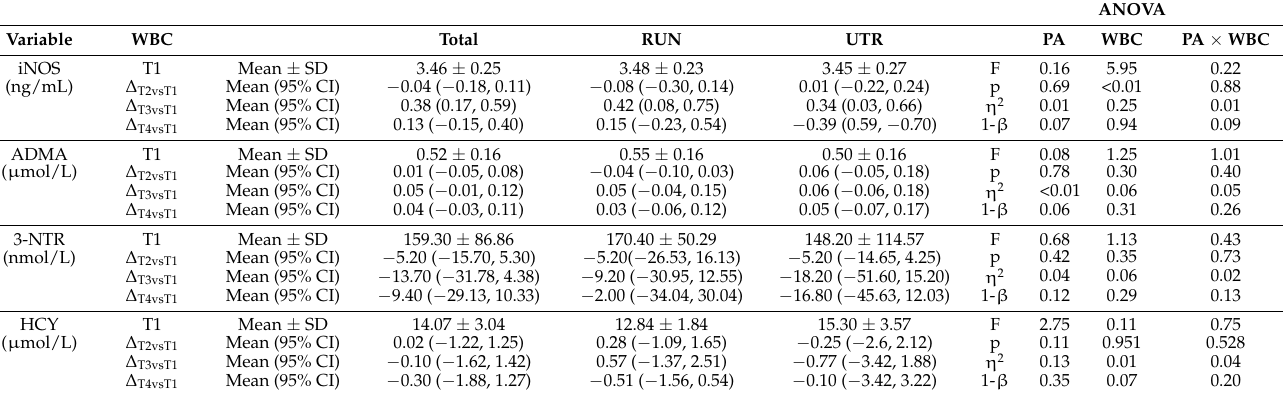
Table 2. Changes in nitro-oxidative stress indices concentration in the period of whole-body cryotherapy (WBC) application in the group of long-distance runners (RUN) and in the group of non-training men (UTR).